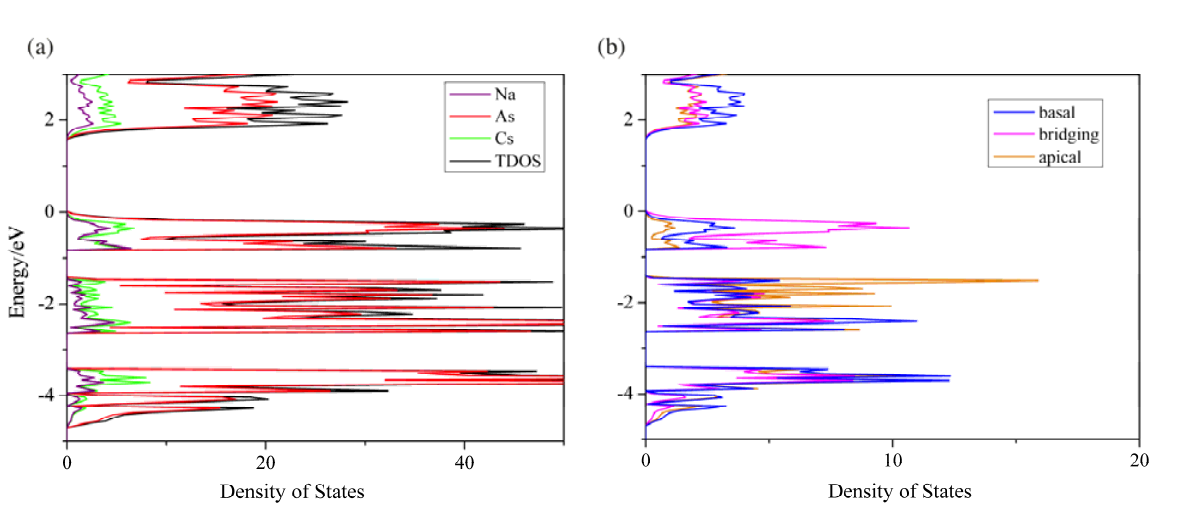
NaAs . (b) Comparison of 2 7